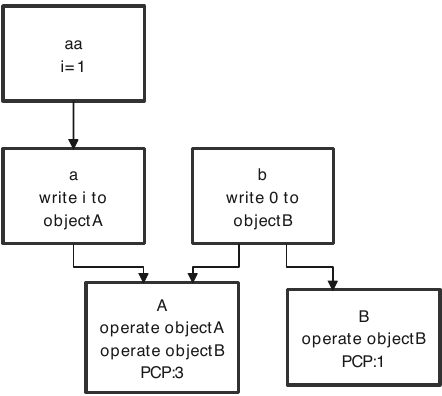
Figure 3. Scoring the potential crash